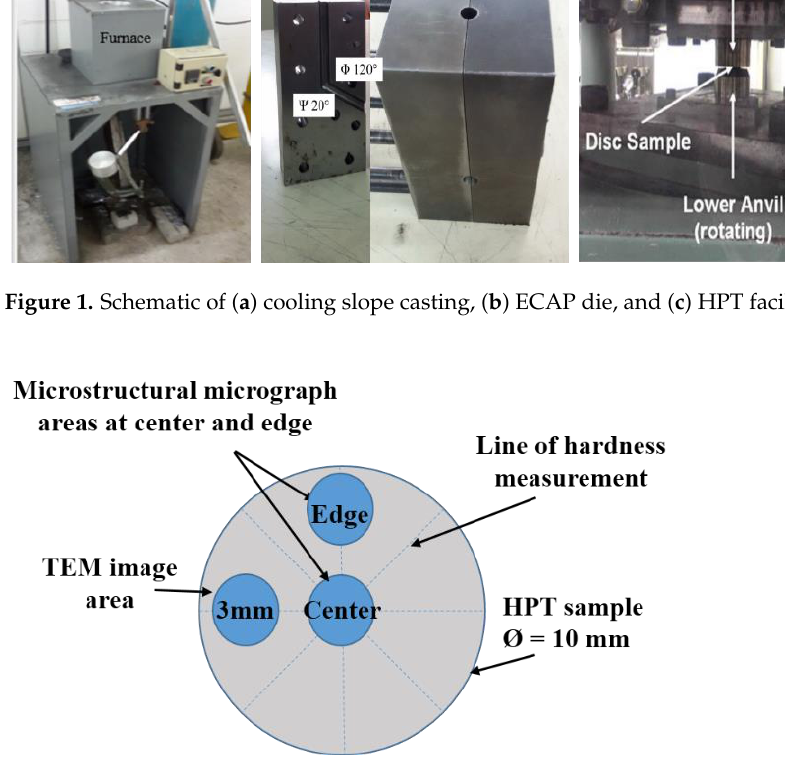
Figure 2. Schematic representation of the HPT disc and the location for measuring the disc hardness and the TEM area.